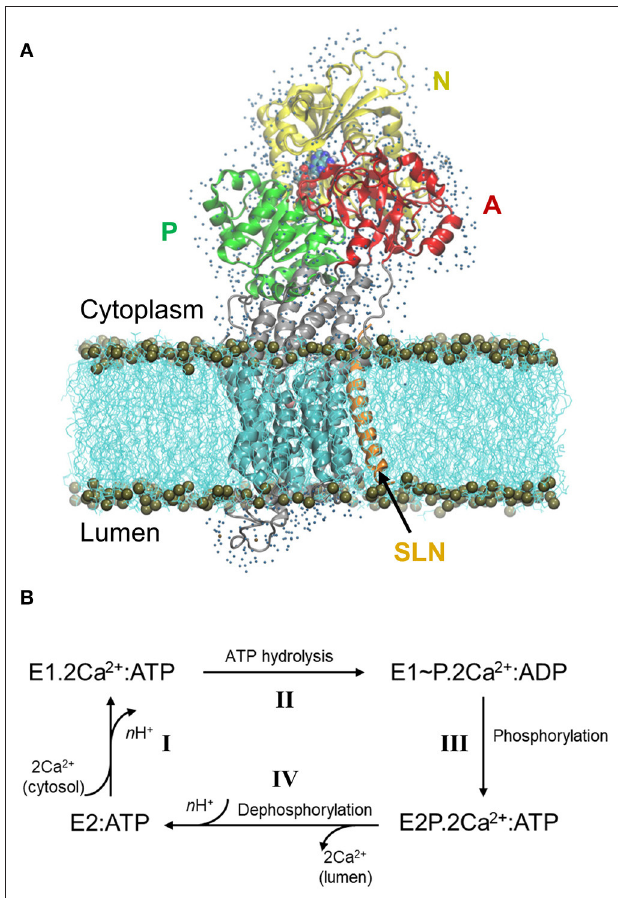
FIGURE 1 | Structure of SERCA1a in the presence of sarcolipin (SLN) and the cycle of Ca 2 + transport. (A) Structure of SERCA1a-SLN embedded in a POPC membrane, with one shell of water surrounding its cytosolic and luminal parts. The N-, P-, and A-domains are in yellow, green, and red, respectively, the TM domain in cyan and the rest of the protein in gray. SLN is in orange and ATP is in spheres colored according to atom name, C: cyan, N: blue, O: red, P: tan, and Mg 2 + : pink. The membrane is in cyan lines with phosphorus atoms in tan spheres. Finally, water molecules are blue dots. (B) Simplified cycle of the Ca 2 + transport from the cytoplasm to the sarcoplasmic reticulum